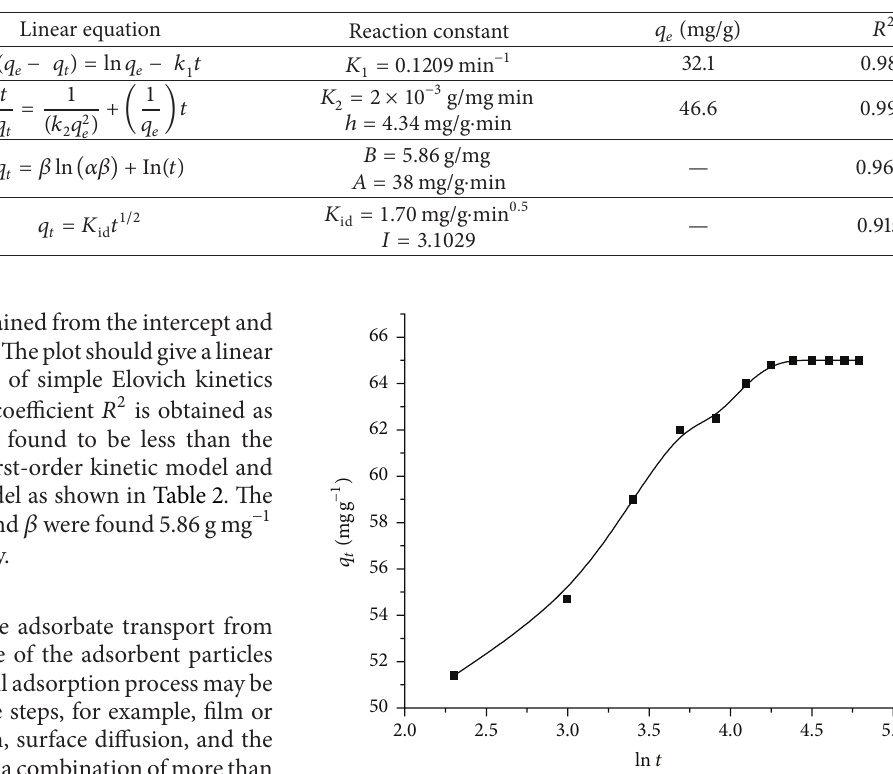
Table 2: Kinetic parameters for adsorption of Hg(II) onto ALP biomass at 303K.